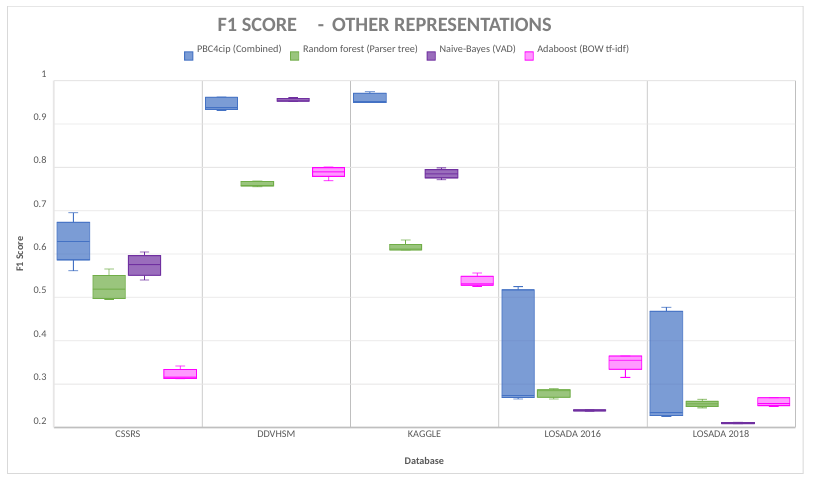
Figure 6. A comparison plot of the F1 score for the best proposed representation using PBC4cip, and other classifiers found in the literature.